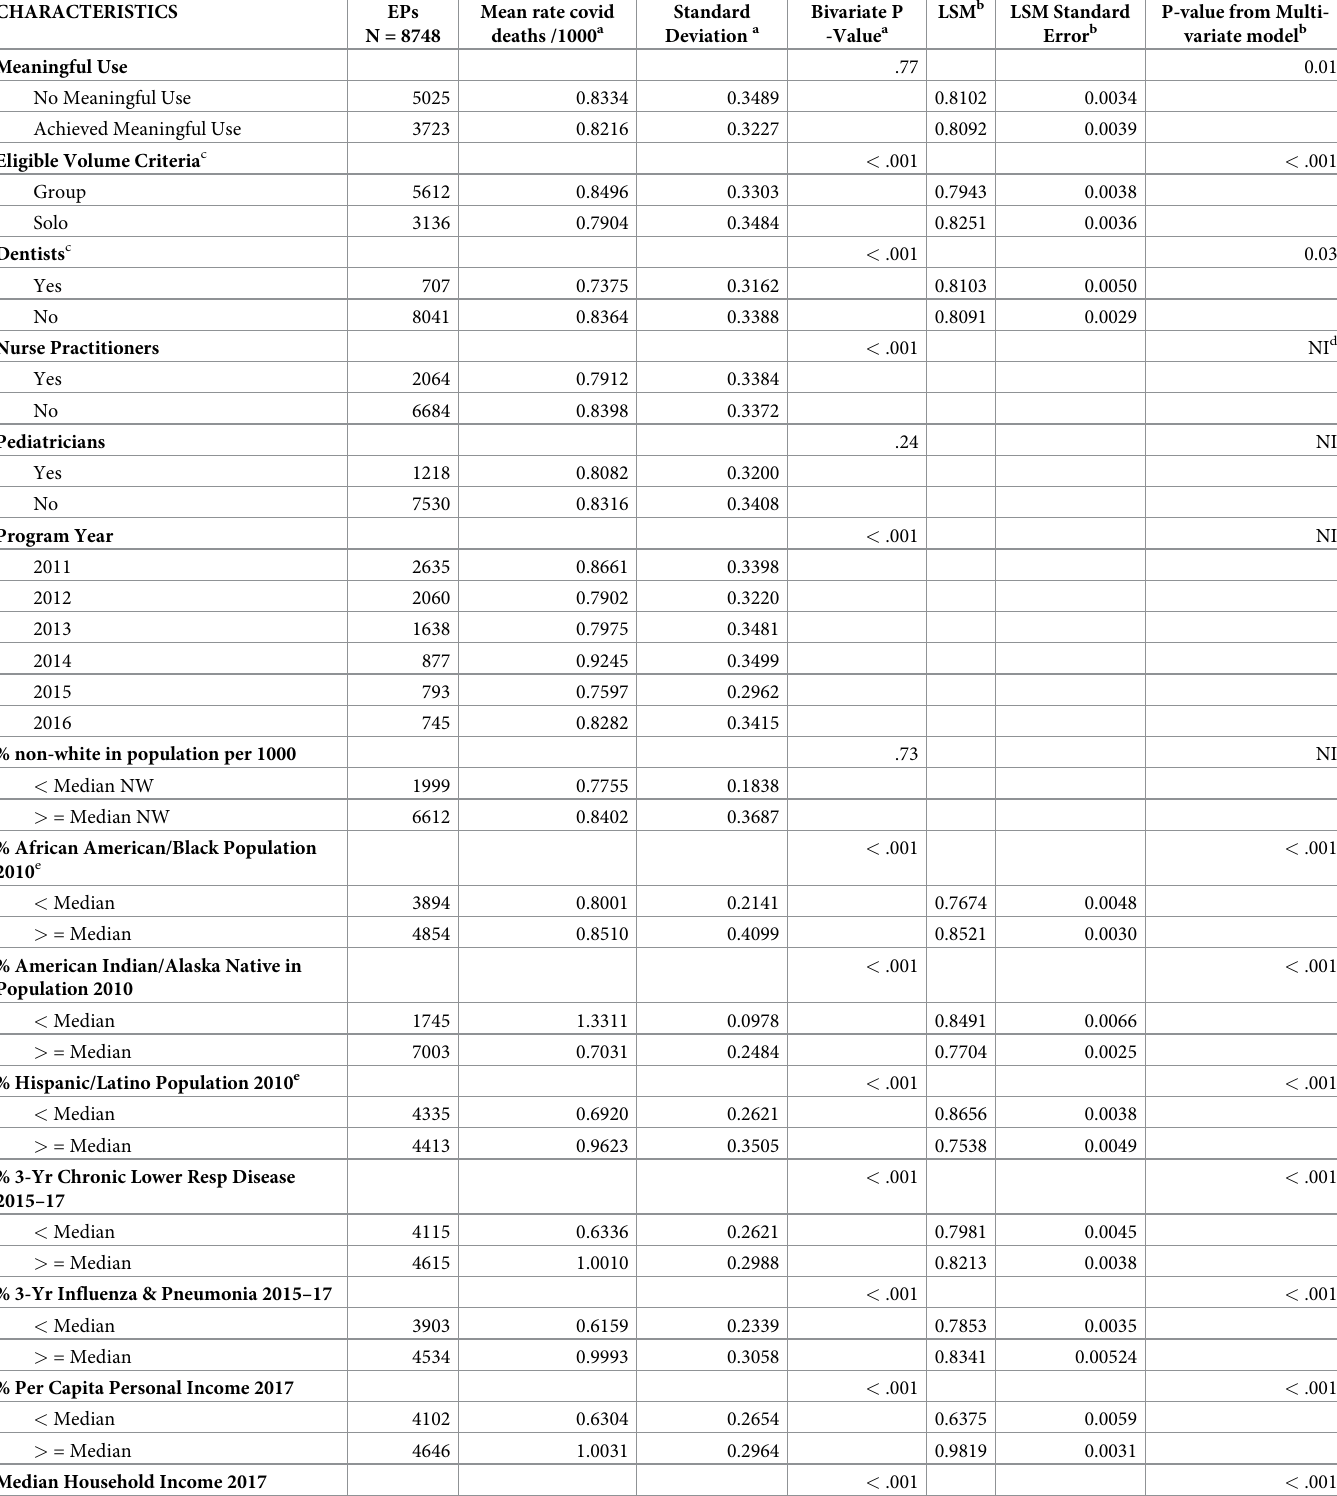
Table 1. Characteristics associated with COVID-19 death rates among Florida county populations (per